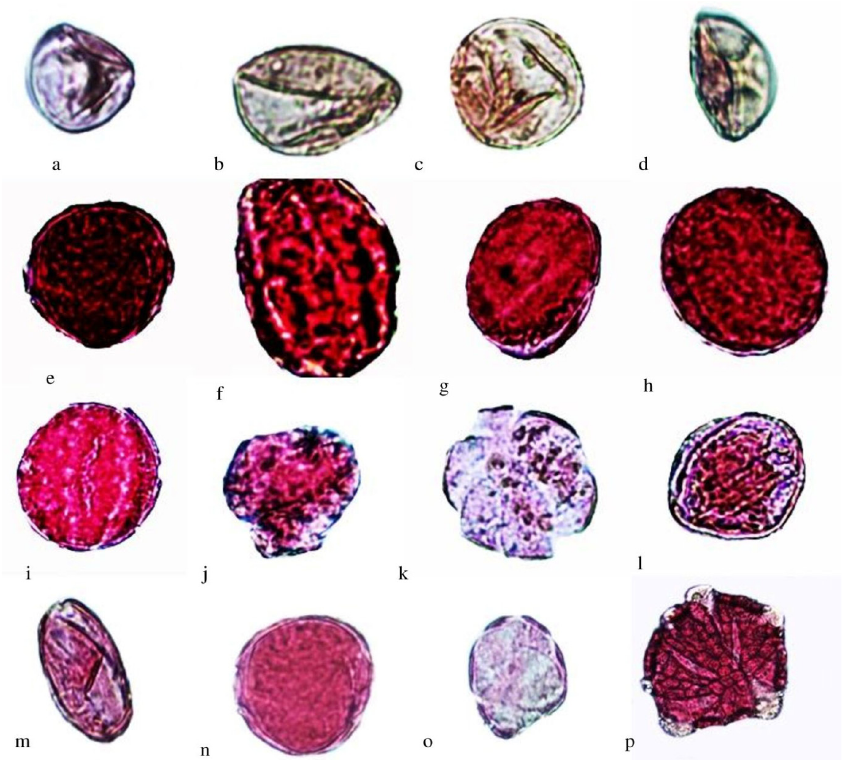
Figure 5. Optical microscopy images of pollen. ( a ) Chenopodiaceae. ( b ) Cupracaceae. ( c , d ) Liliaceae. ( e – l ) Asteraceae. ( m – p ) Poaceae.